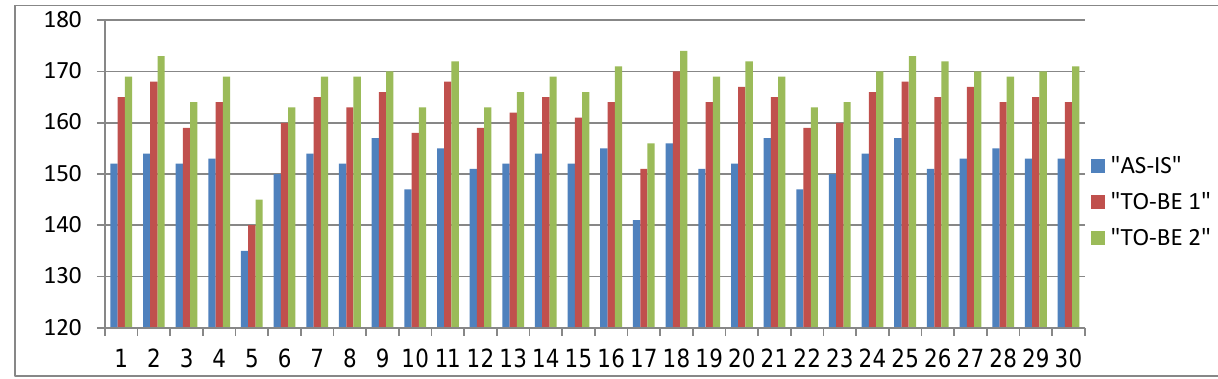
Fig. 8. Scenarios comparison